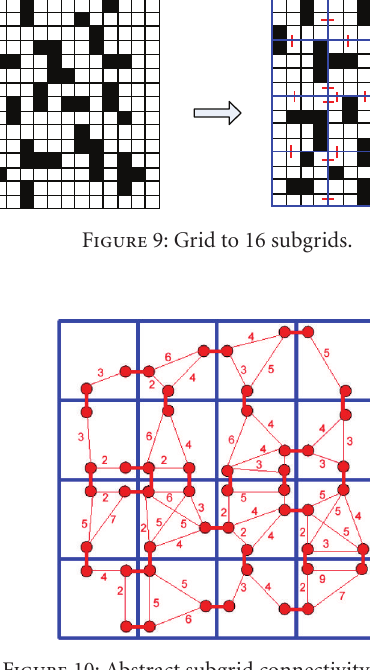
Figure 10: Abstract subgrid connectivity graph.